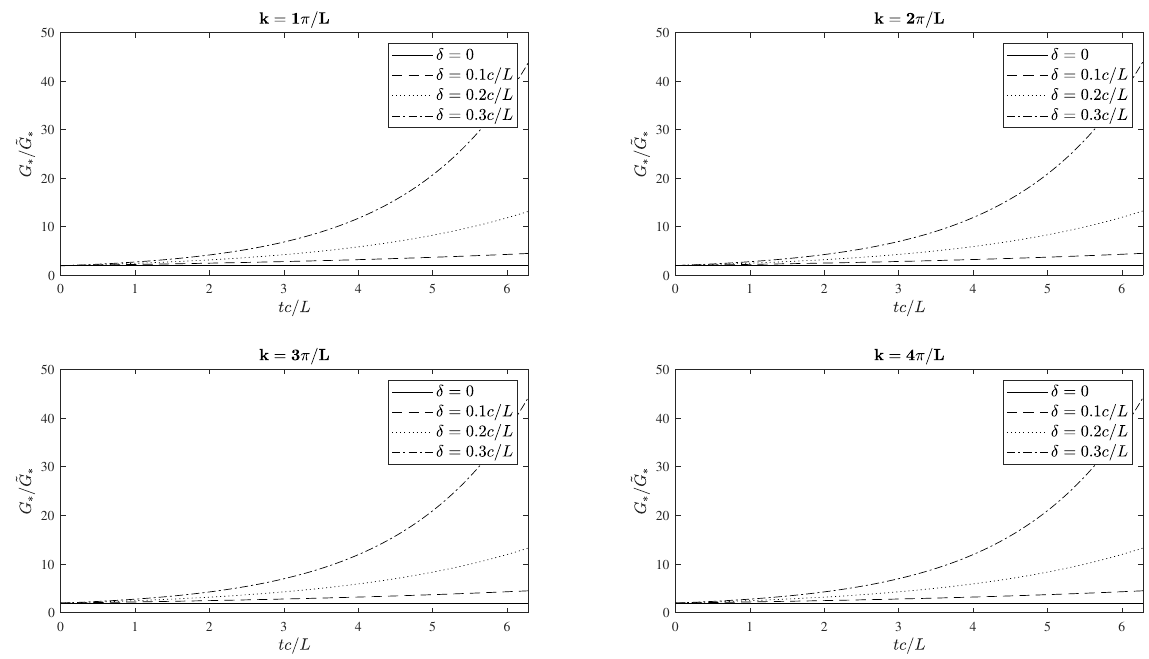
Figure 6. Energy of total oscillation G ∗ divided by the energy of free oscillation ˜ G ∗ as a function of dimensionless time tc / L . The plots are shown as functions of k and δ L / c whereas in all cases k = n π / L